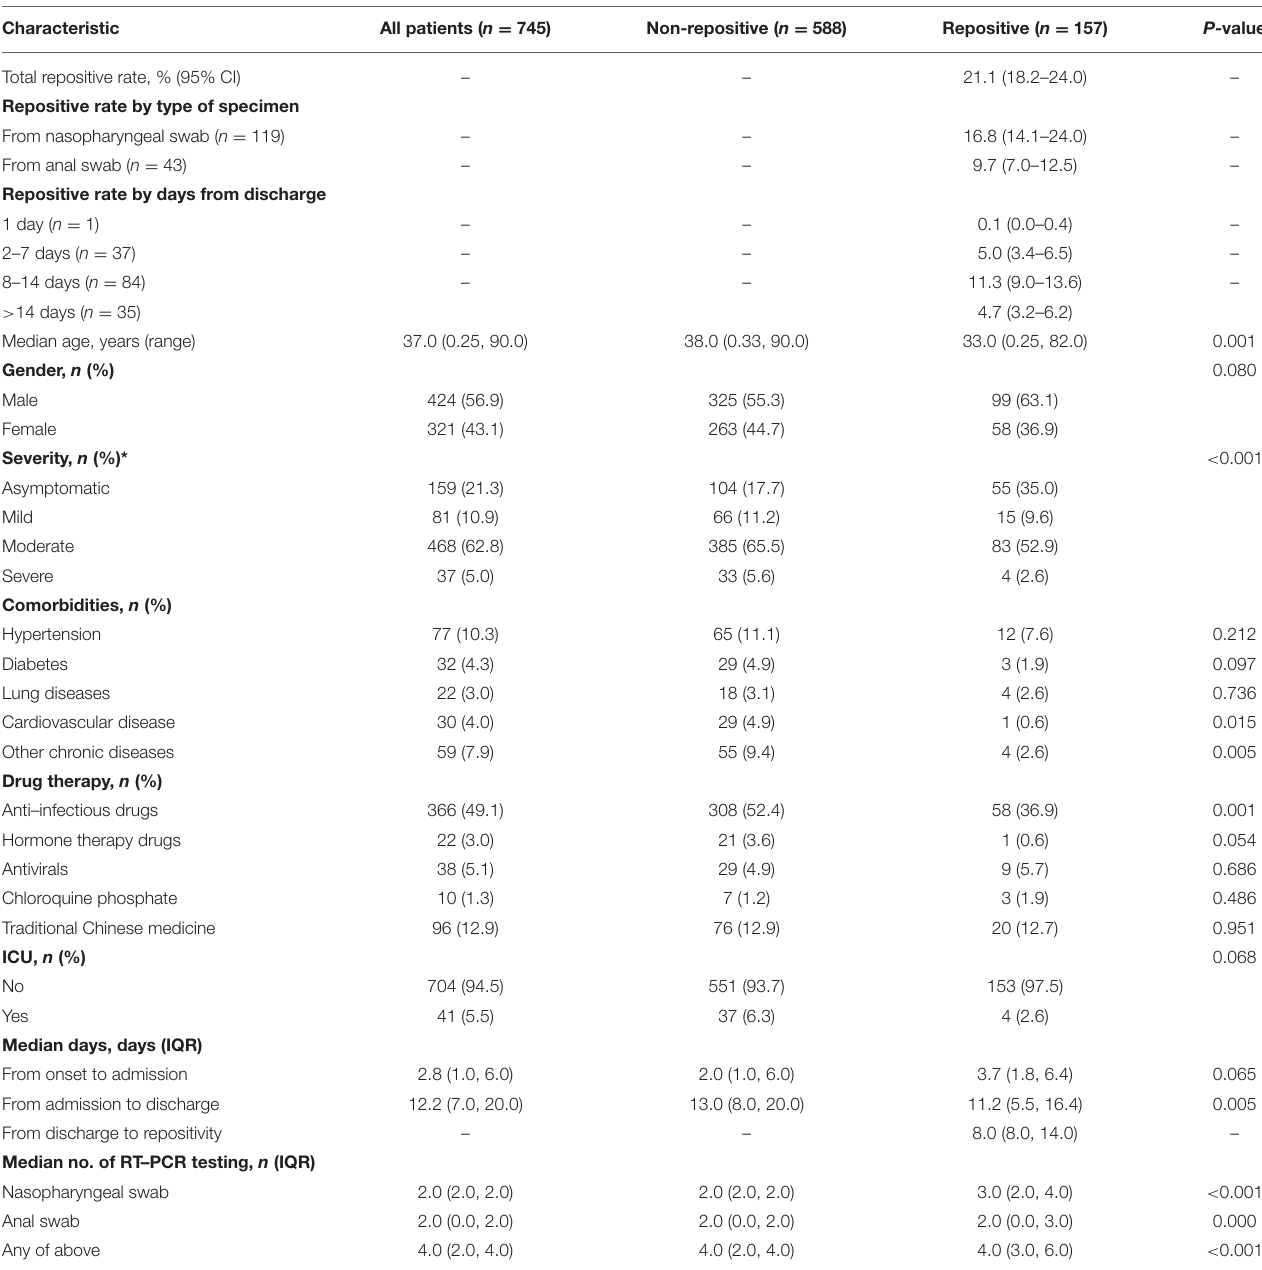
TABLE 1 | Characteristic of 157 repositive and 588 non-repositive patients with